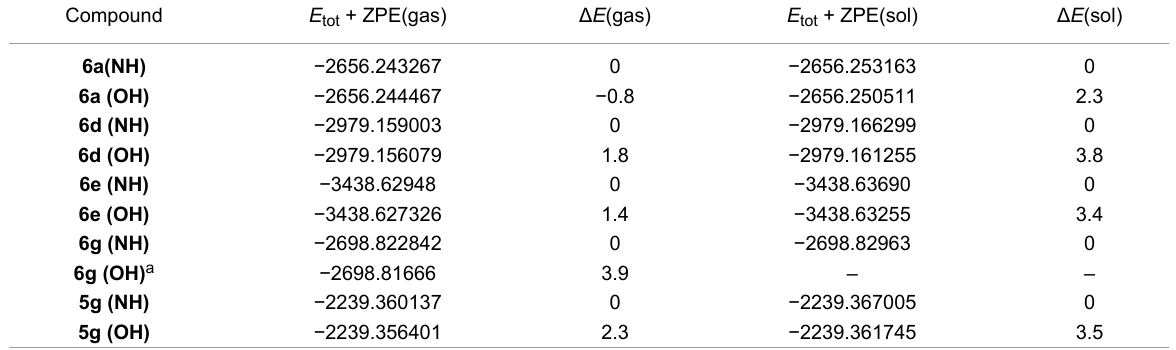
Table 2: Total energies with zero-point energy correction ( E tot + ZPE, а .u.) and relative energies ( Δ E , kcal/mol) of the NH and OH tautomeric forms of compounds 5 and 6 calculated using the PBE0/6-311+G** method in the gas phase and in DMSO solution.